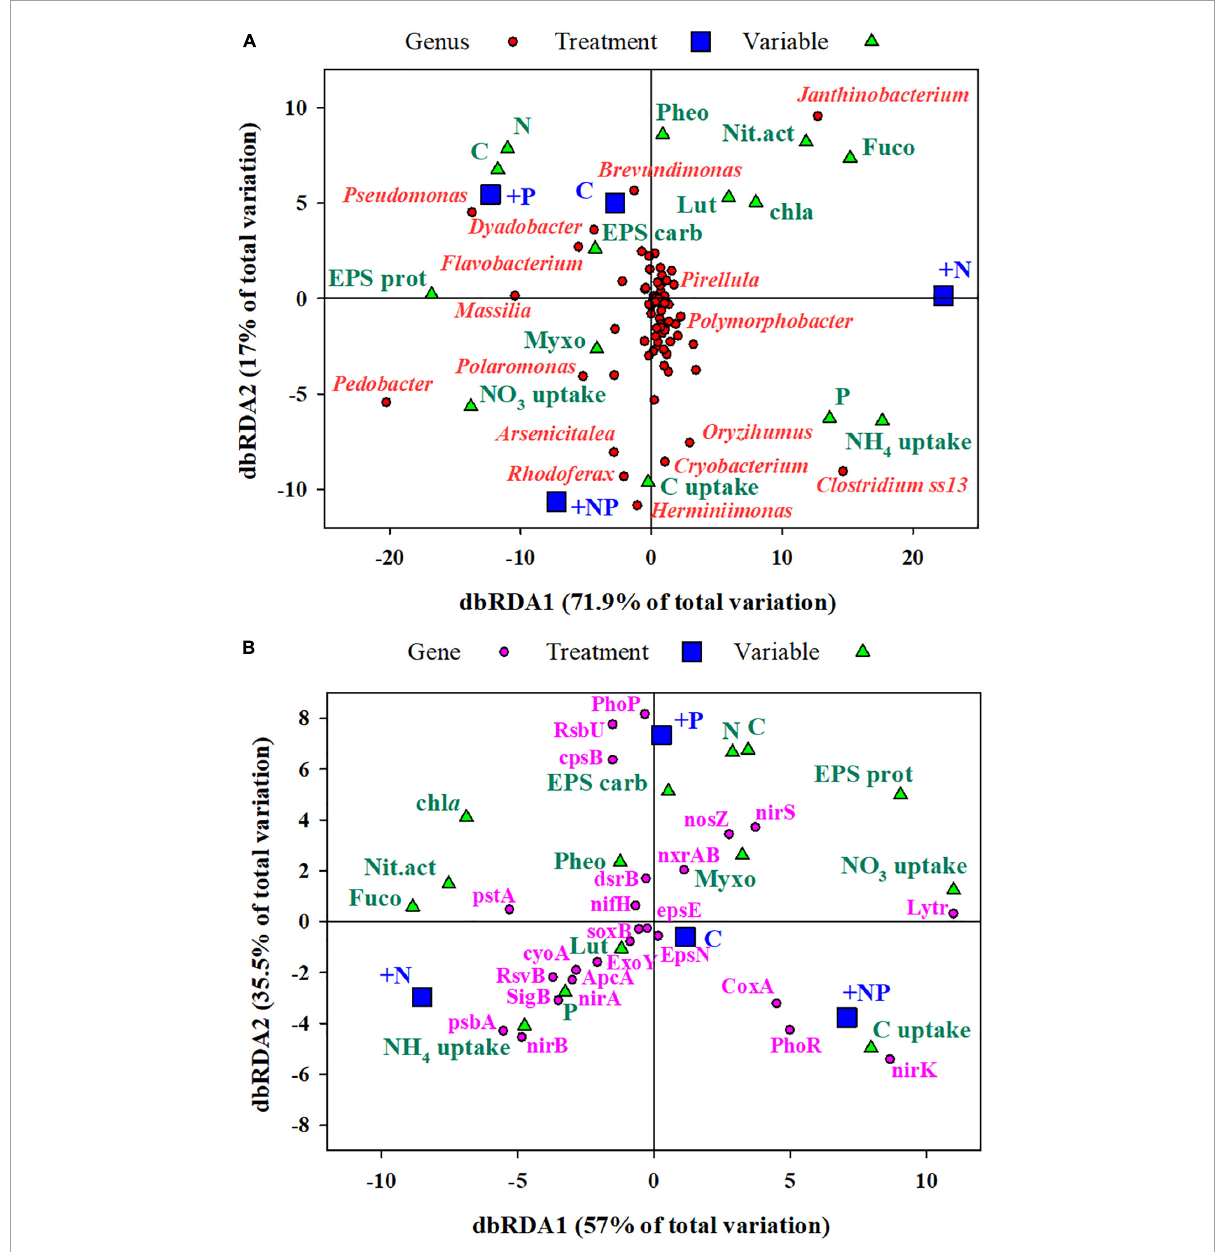
FIGURE7 (A) Distance-based redundancy analysis (db-RDA) of (A) all the ZOTUs (grouped at the taxonomic level of genus) and (B) selected genes ( Supplementary Table 1 for description) from Picrust2, analyses of 16SrRNA amplicon sequencing. Predictor variables for both dbRDA were C, carbon; N, nitrogen; P, EPS carb, EPS carbohydrates; EPS prot, EPS protein; chla, chlorophyll a ; Myxo, myxoxanthophyll; Fuco, fucoxanthin; Lut, lutein; Pheo, pheophytin; C uptake, NO 3 uptake, NH 4 uptake, and Nit.act, nitrogenase activity. Genera with more than 0.1% of the total reads in all treatments have been